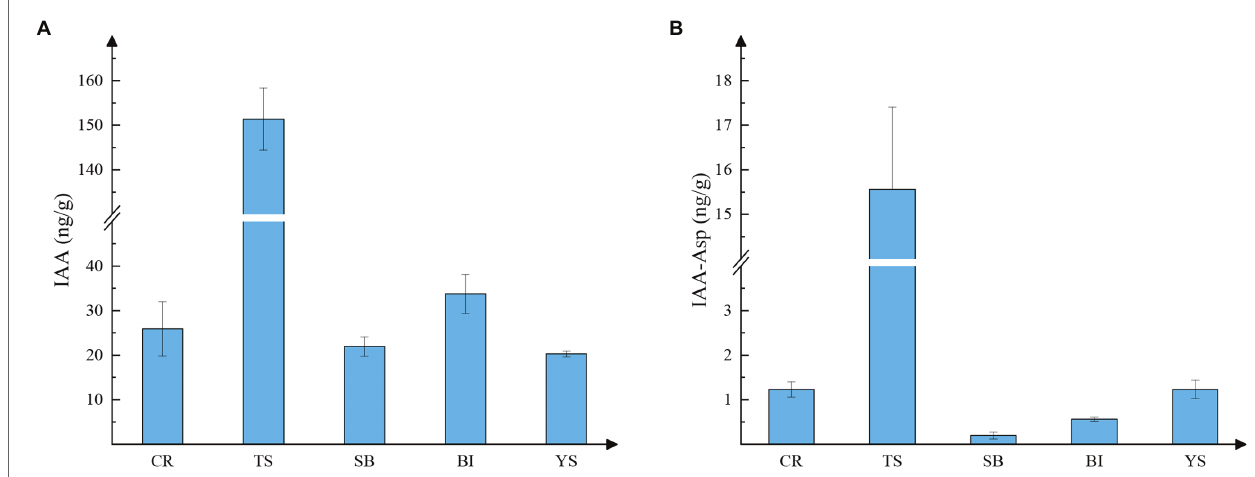
FIGURE 3 | Auxin content of different tissues. CR root tip (the tip of the bamboo root growing out of the base of the bamboo shoot), TS tip of shoot, SB sheath blade (the upper component of culm sheaths, the base is connected to the tip of sheath and is the metamorphic leaf of bamboo shoot), BI bamboo shoot internode 1/5 from the tip, and YS young sheath. (A) Content of IAA; (B) Content of IAA-ASP